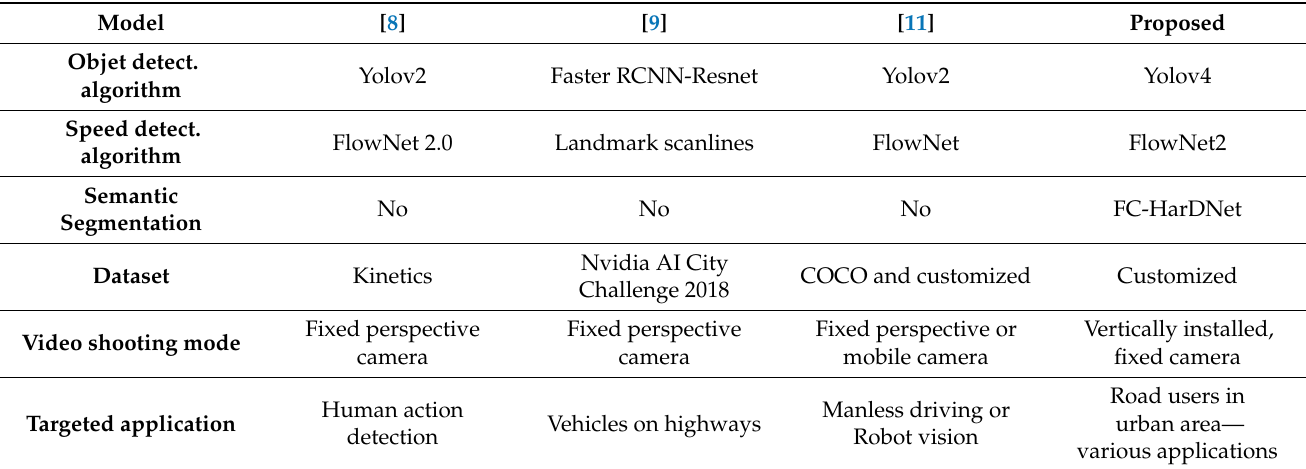
Table 6. Comparative specifications with other similar